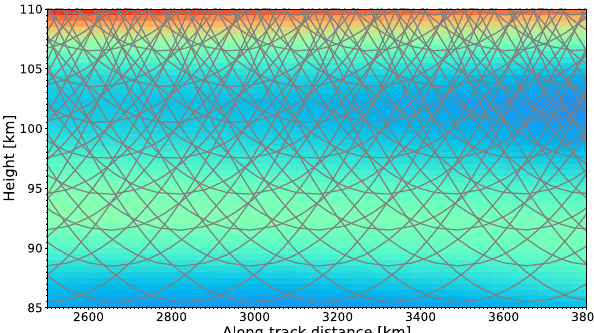
Figure 9. Central track of limb sounding measurements with a viewing azimuth angle of 0 ◦ . Note that just for display in this fig- ure the sampling distance is 3km in the vertical and 165km in the along-track direction. However, the simulated sweep mode has a better spatial resolution: 1.5km in the vertical and 40km in the along-track